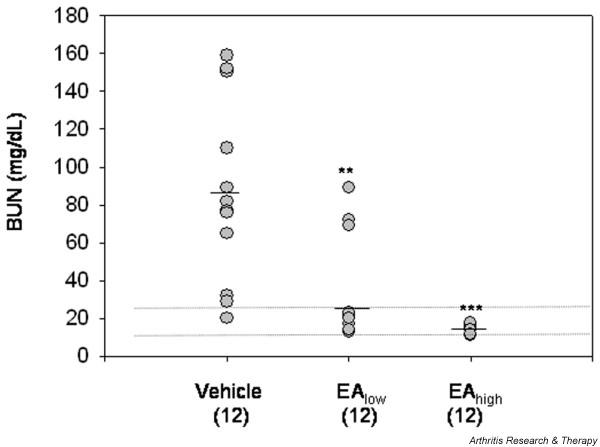
Renal function (blood urea nitrogen (BUN)) of the NZB/WF1 mice after treatment with vehicle or the ethyl acetate (EA) extract of Tripterygium wilfordii Hook F. Serum was collected from the animals for assay of BUN before euthanasia. Dotted lines show the normal range for BUN (17 to 28 mg/dl). Numbers in parentheses indicate the animals examined. The horizontal bars indicate the median values of each group. **p < 0.001, vehicle versus EAlow; ***p < 0.01, vehicle versus EAhigh.